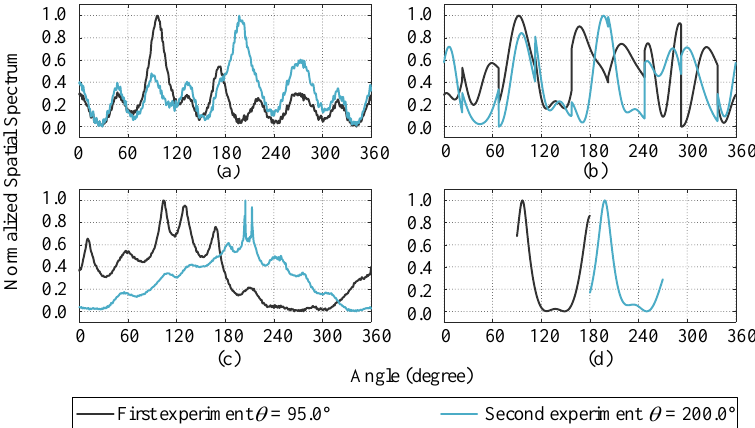
Figure 10. Four algorithms DOA spatial spectrum for two angle experiments ( a ) DA-MUSIC; ( b ) S-MUSIC; ( c ) Capon-like; ( d ) Two-stage fast DOA estimation.